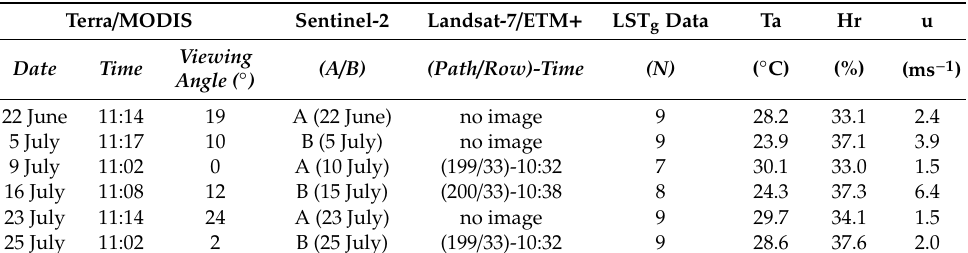
Table 1. List of satellite images used in this study, with indication of overpass time. Number of crop fields where LST g data were measured per date is included (N). Meteorological conditions in the area at the overpass time are also listed: air temperature (T a ), relative humidity (H r ) and wind speed (u). All dates correspond to the year 2018.